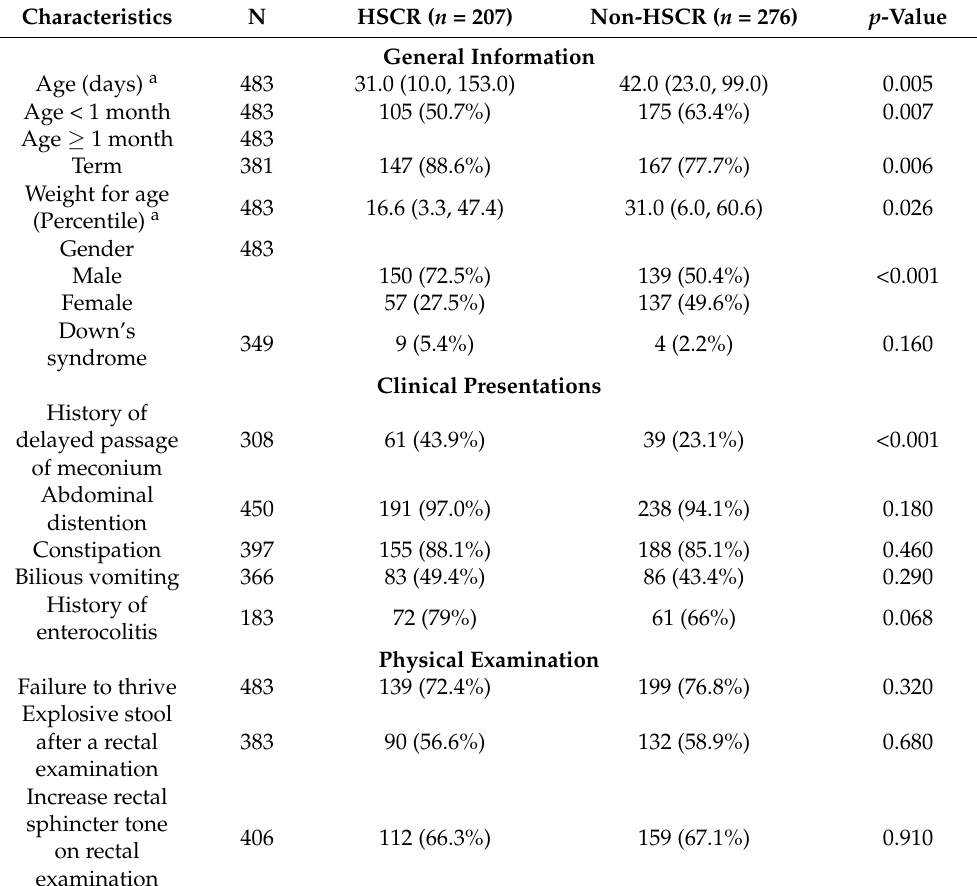
Table 1. General information, clinical presentations, and physical examination of HSCR and non- HSCR patients in Chiang Mai University Hospital from 2006 to 2020 (all 483 cases).